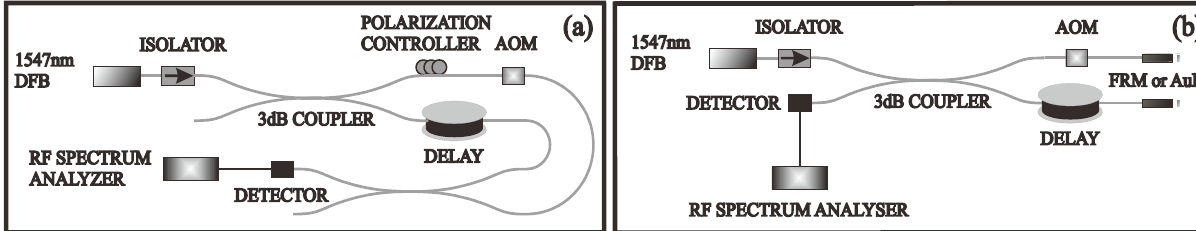
Figure 2. Delayed self-heterodyne interferometer (DHSI) technique using ( a ) a Mach-Zehnder interferometer (MZI); and ( b ) a Michelson interferometer (MI) with FRMs. (AOM: Acousto-Optic Modulator, FRM: Faraday Rotator Mirror, RF: Radio